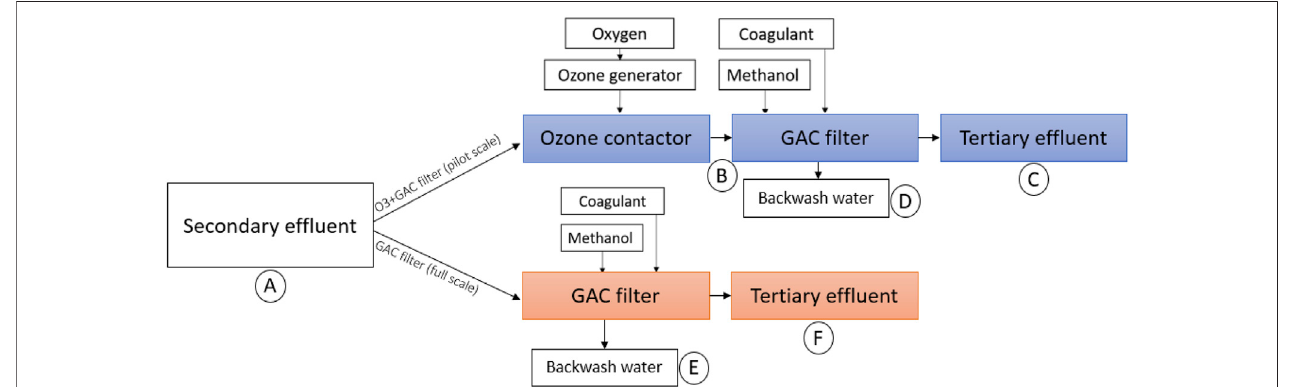
FIGURE 2 | Process steps and sampling locations (A – F) in the Ozonation + GAC fi ltration pilot plant (top) and the full-scale GAC fi lter